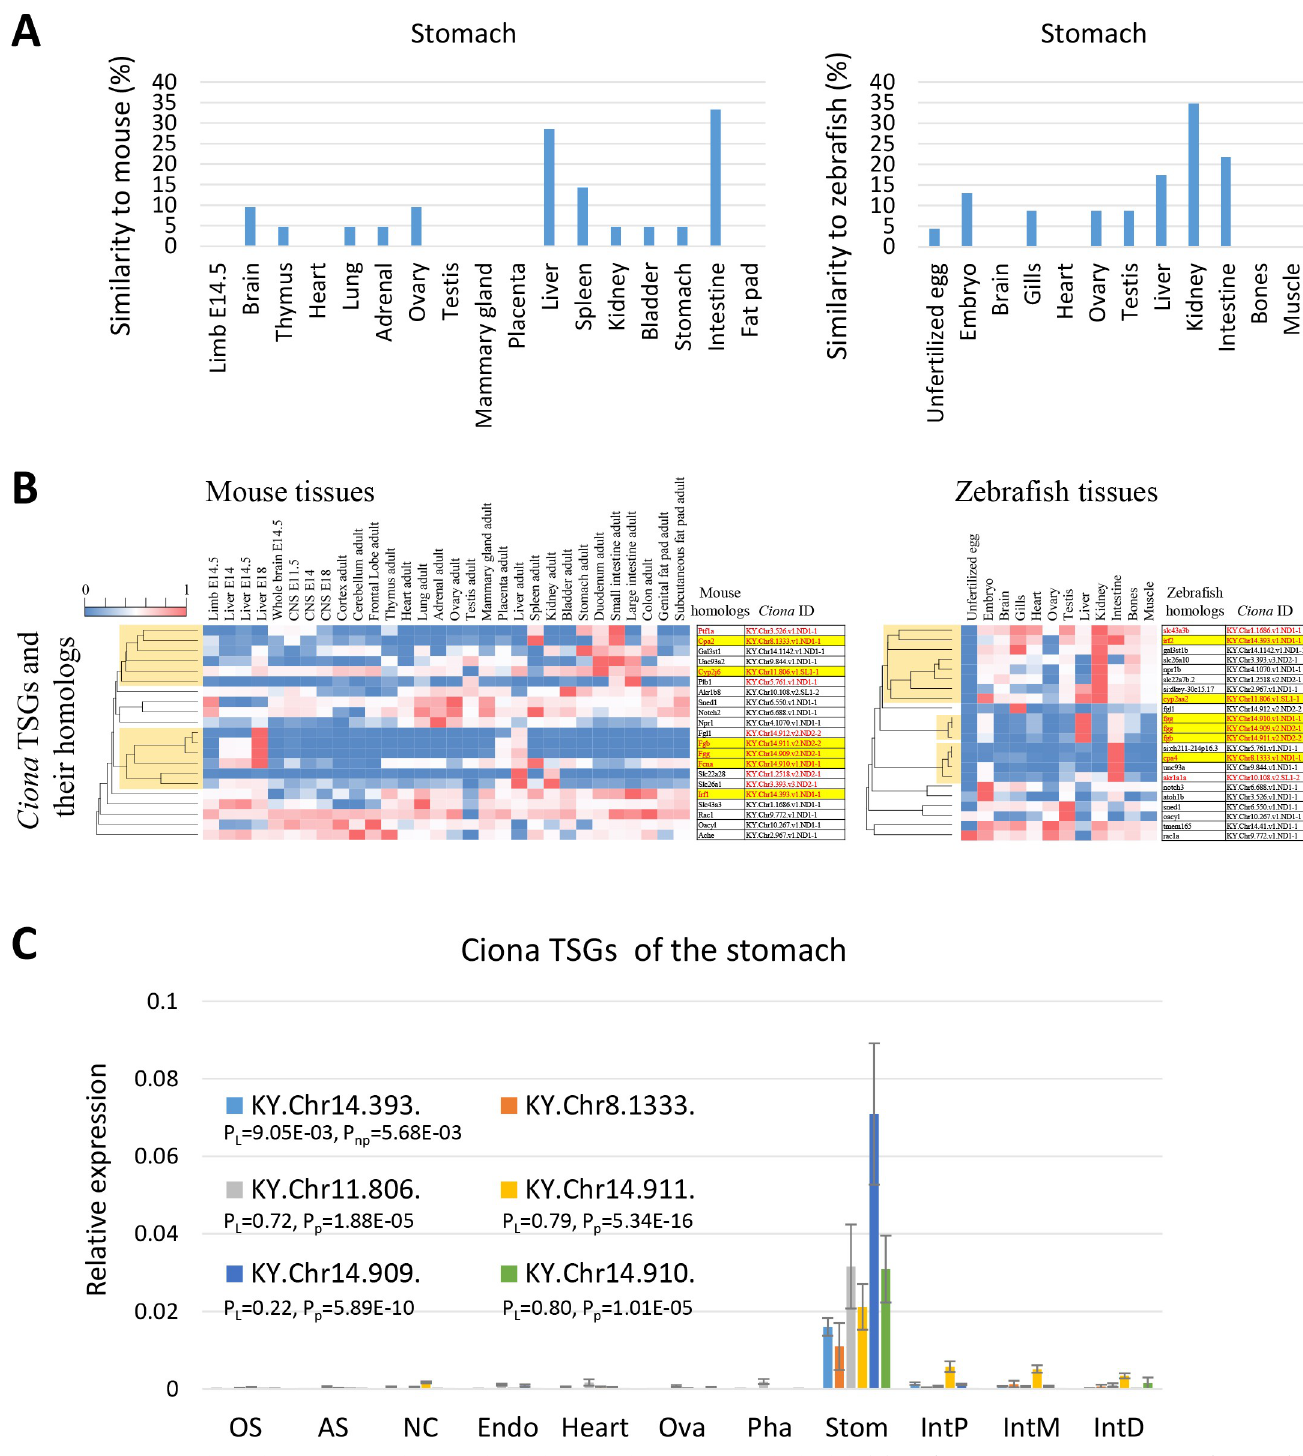
Fig 4. Comparative analyses of Ciona TSGs in the stomach and their homologs in mouse and zebrafish. (A) Similarities in gene expression patterns between the Ciona TSGs in the stomach and their homologs in mouse (left) or zebrafish (right) tissues were calculated as in Fig 3A. Approximately 30% of the homologous genes were highly expressed in the mouse liver and intestine, while 20–35% were highly expressed in the zebrafish liver, kidney, and intestine. (B) Clustering by tissue distribution of the homologous genes in mice and zebrafish. The heat maps are shown as in Fig 3B. Clusters of highly expressed genes in the mouse brain, intestine, zebrafish kidney, liver, and intestine are shown in orange. (C) Stomach-specific expression of Ciona TSGs in the stomach was confirmed by qRT-PCR (n = 3–4). Data are presented as in Fig